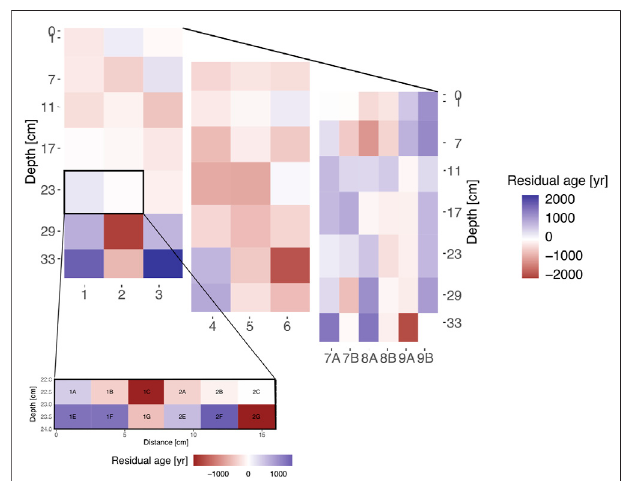
FIGURE 6 | Three-dimensional view on age-heterogeneity within the core. Residuals to the respective mean of each depth layer are shown for all twelve sub-cores. They generally increase with depth and show the largest deviations towards the bottom of the core. Residuals from the small- volume bulk samples are compared to the overall mean of all twelve samples and are shown in the